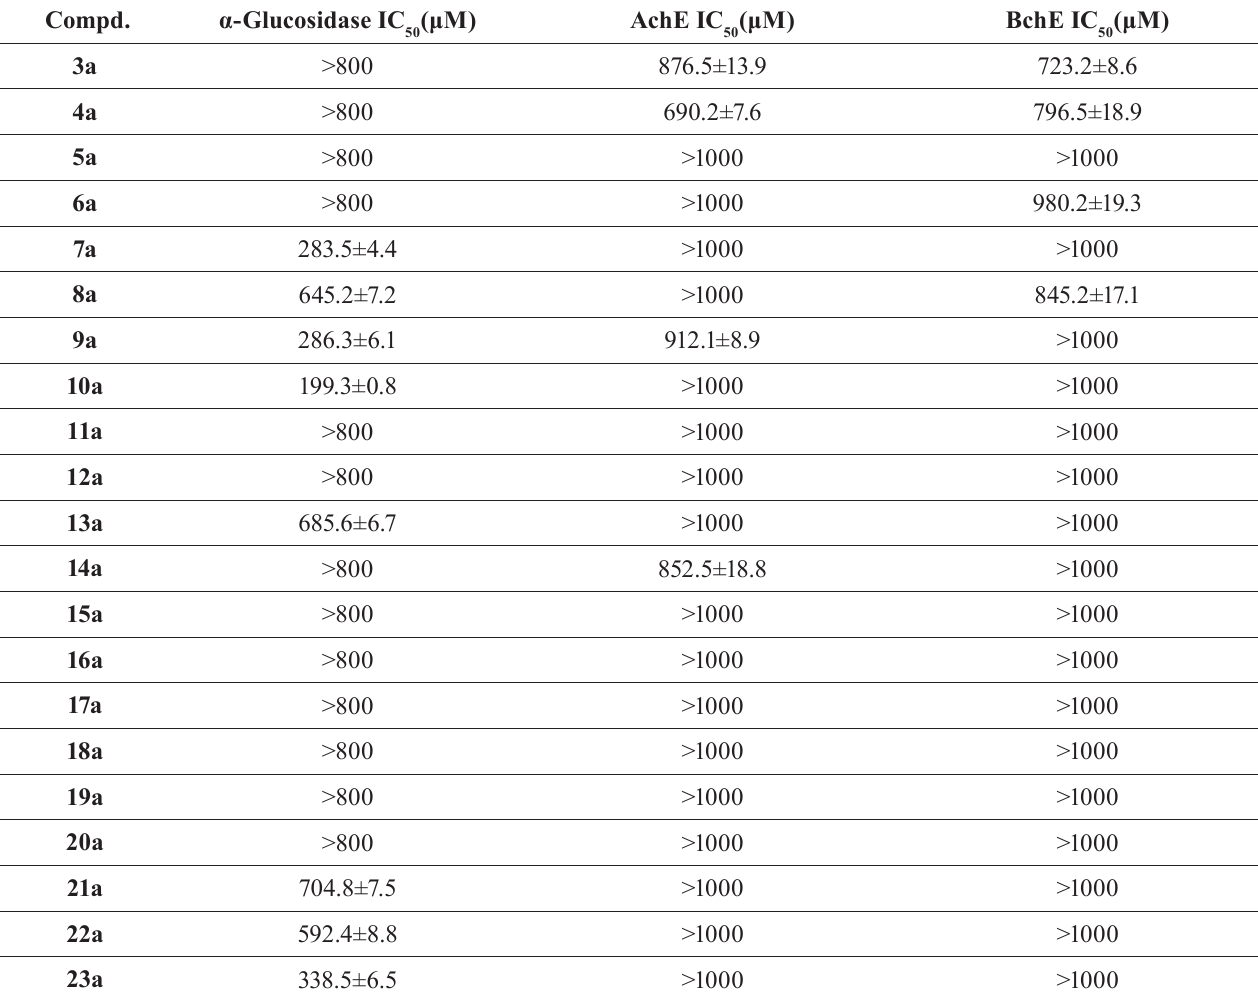
TABLE II - Hypoglycemic activity, anticholinesterase activity of compounds 3a-32a